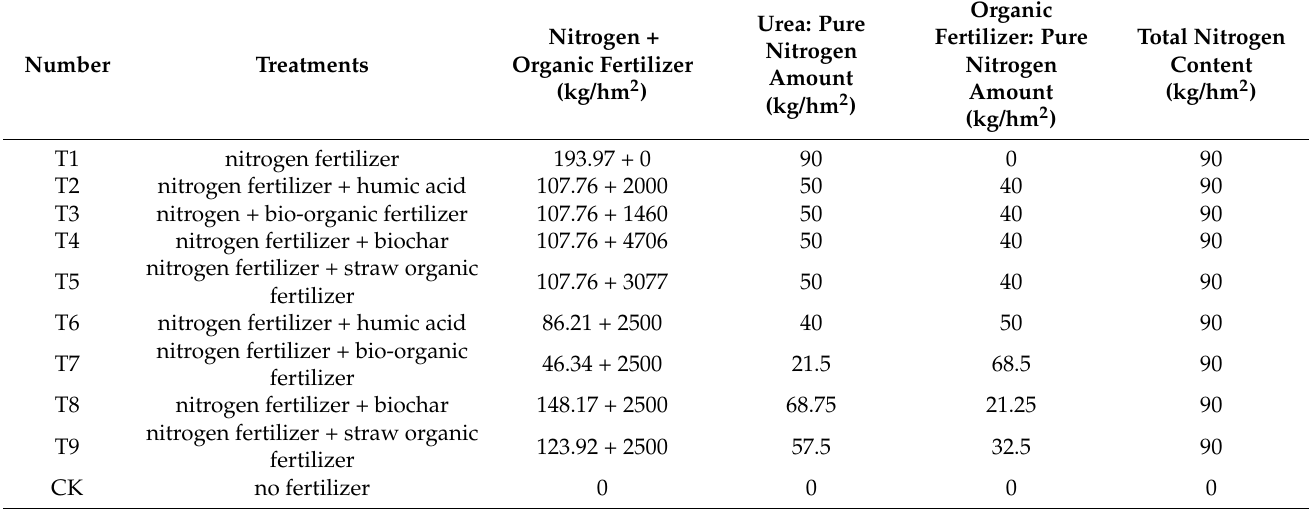
Table 2. Experimental design